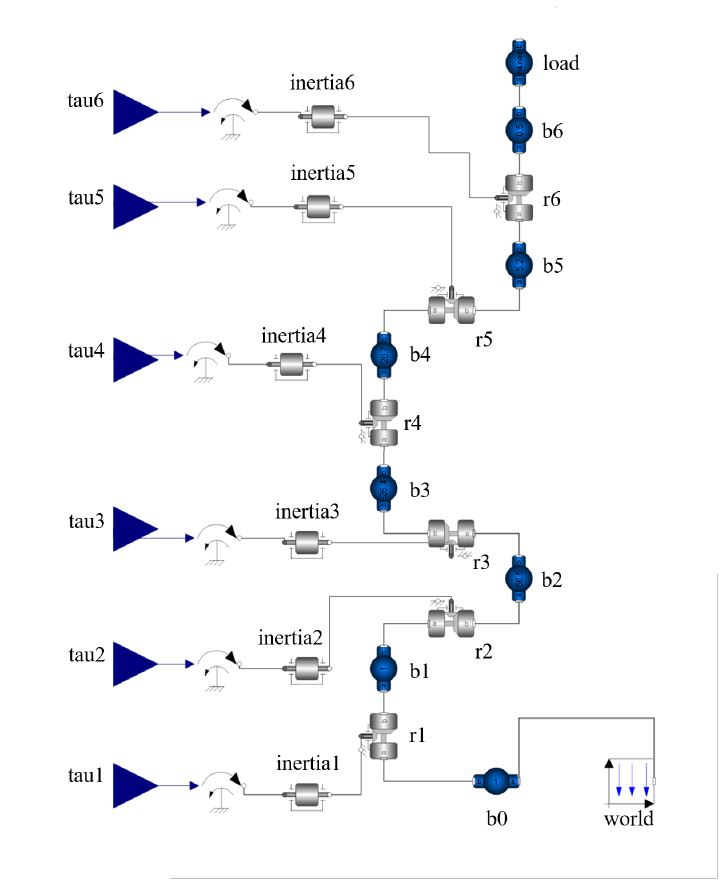
Figure 2. Modelica model of the manipulator.